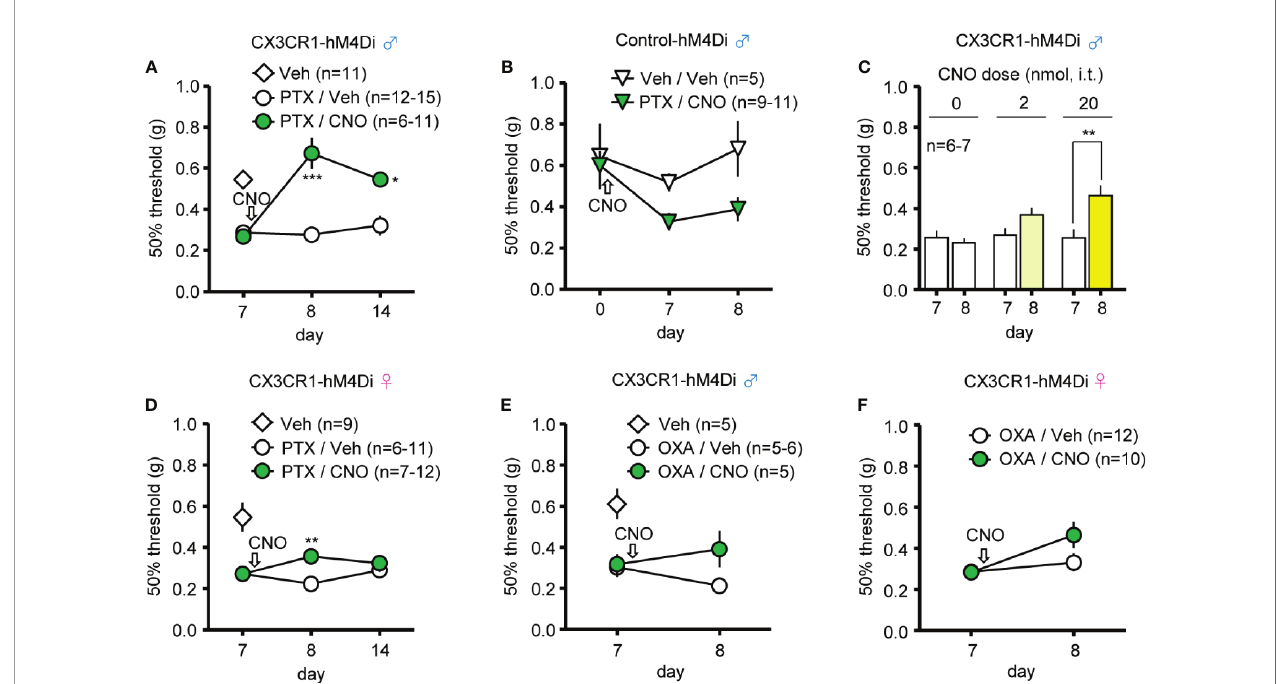
FIGURE 4 | CNO effect on chemotherapy-induced neuropathic pain (CINP) caused by paclitaxel (PTX) and oxaliplatin (OXA) in CX3CR1-hM4Di mice. PTX (4 mg/kg) or OXA (5 mg/kg) was i.p. administered to mice four times every second day (on days 0, 2, 4, and 6), and CNO or Veh was administered after pain assessment as indicated by arrows. The 50% paw withdrawal threshold was assessed by the up – down method using the von Frey test. (A , B) Effect of CNO (10 mg/kg, i.p.) on the 50% paw withdrawal threshold in male CX3CR1-hM4Di and Control-hM4Di mice after PTX administration. (C) Dose-dependent effect of CNO (2 or 20 nmol, i.t.) on PTX-induced mechanical allodynia in male CX3CR1-hM4Di mice. (D) Effect of CNO (10 mg/kg, i.p.) on PTX-induced mechanical allodynia in female CX3CR1-hM4Di mice. (E, F) Effect of CNO (10 mg/kg, i.p.) on OXA-induced mechanical allodynia in male and female CX3CR1-hM4Di mice. Data are presented as mean ± S.E.M. n = 5-12. p***< 0.001, p** < 0.01, p* < 0.05 vs day 7 before CNO, or